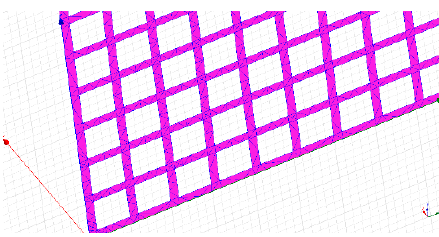
Figure 3. Finite element splitting diagram of the grounding grid surface.